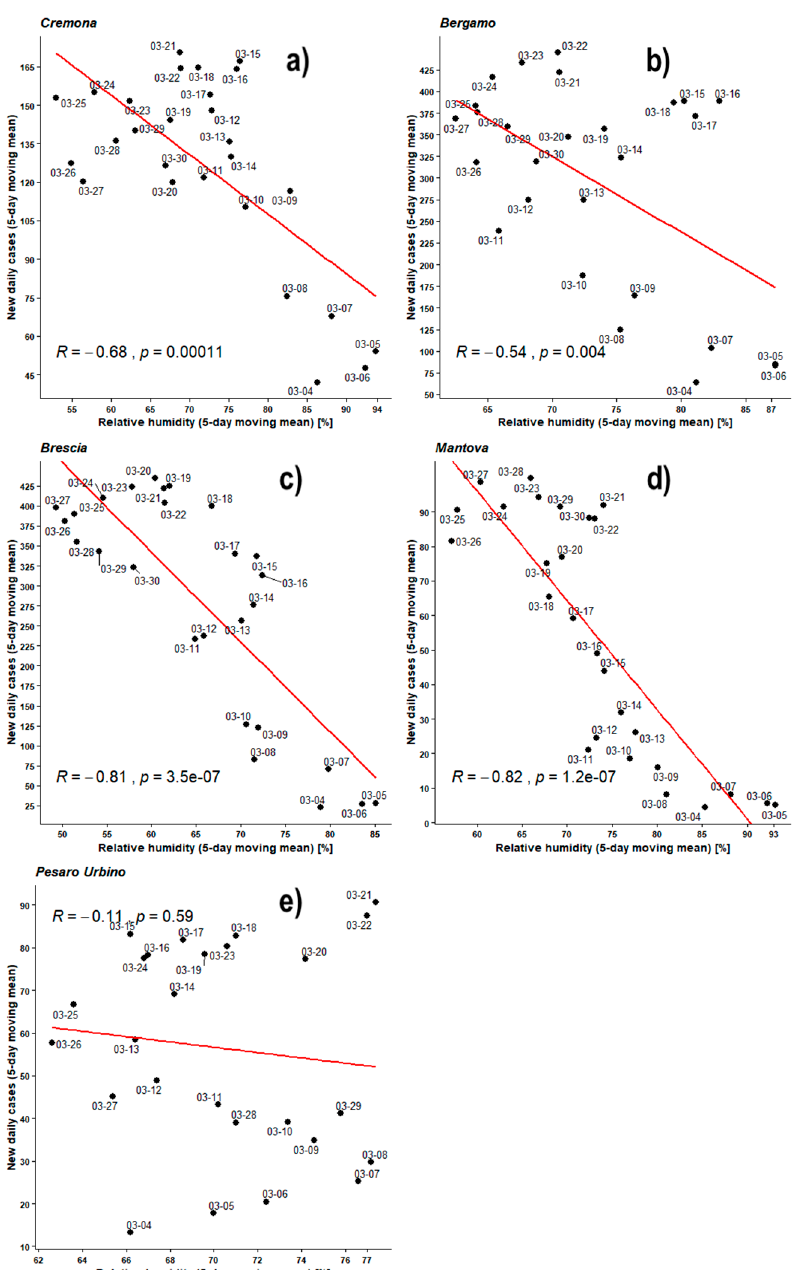
Figure 8. Scatter plot and linear regression for the 5-day moving means of new daily cases of COVID-19 against relative humidity for five Italian provinces: ( a ) Cremona, ( b ) Bergamo, ( c ) Brescia, ( d ) Mantova, ( e ) Pesaro Urbino. Labels report, in MM-DD format, the last day of the moving means. Pearson correlation coefficient is reported as ‘R’ while probability value is reported as ’ p ’.